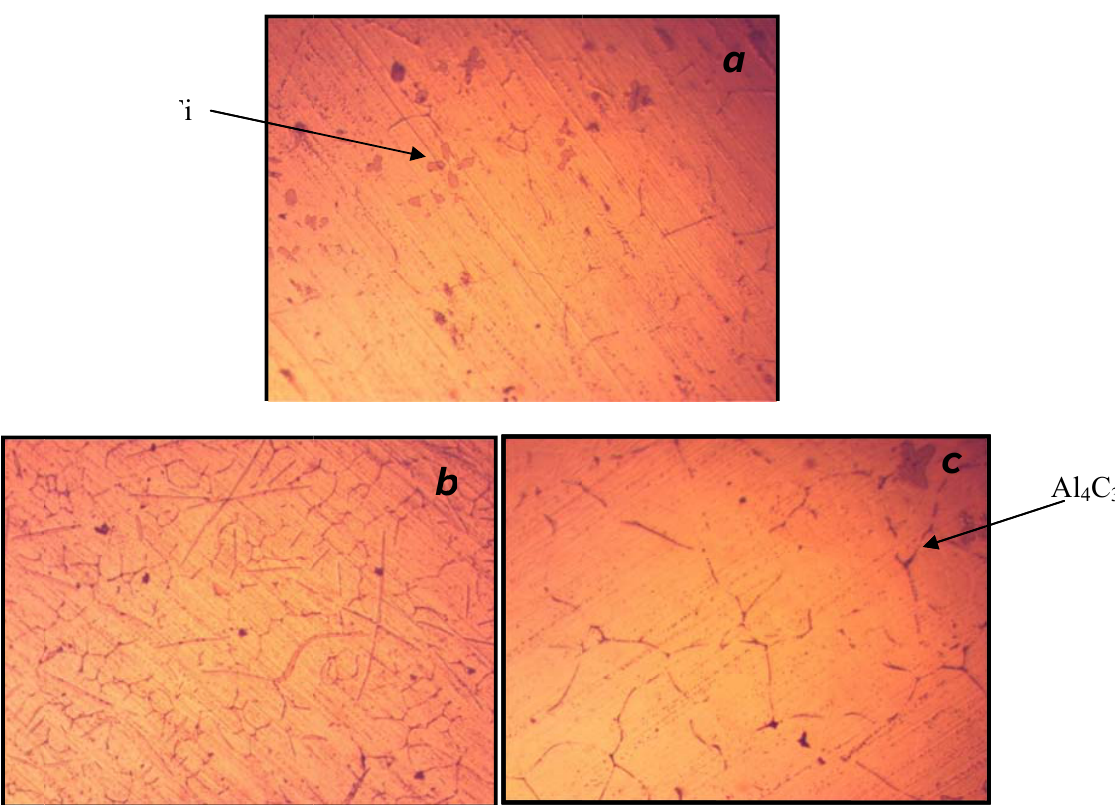
Fig. 2: Op Optical micro